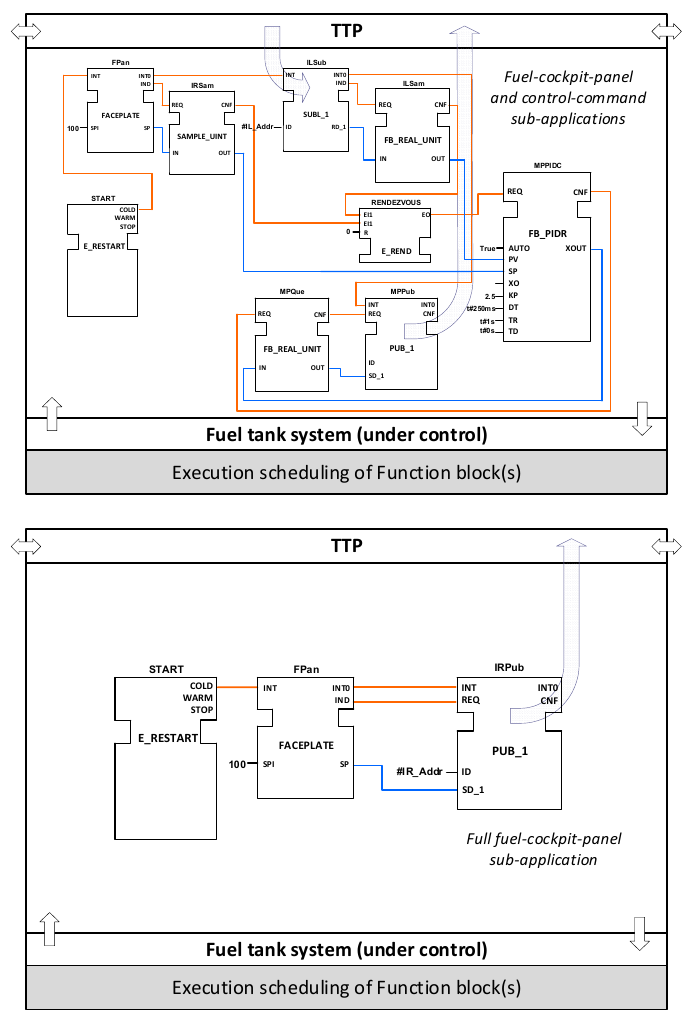
Figure 11. Reassure I.A from CPIOM-Control device: resource configuration for scenario 1 ( top ); Device configuration for scenario 2 ( bottom ).